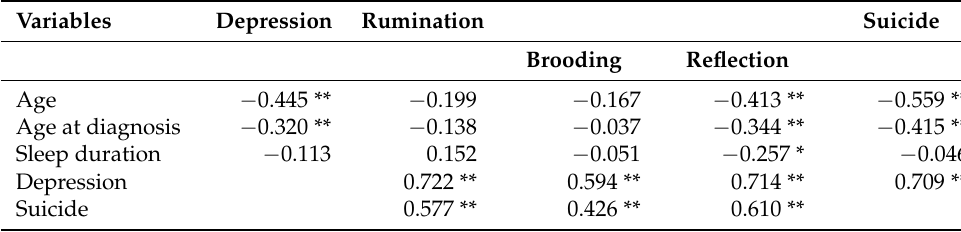
Table 2. The correlation of rumination and suicide ( N = 95).